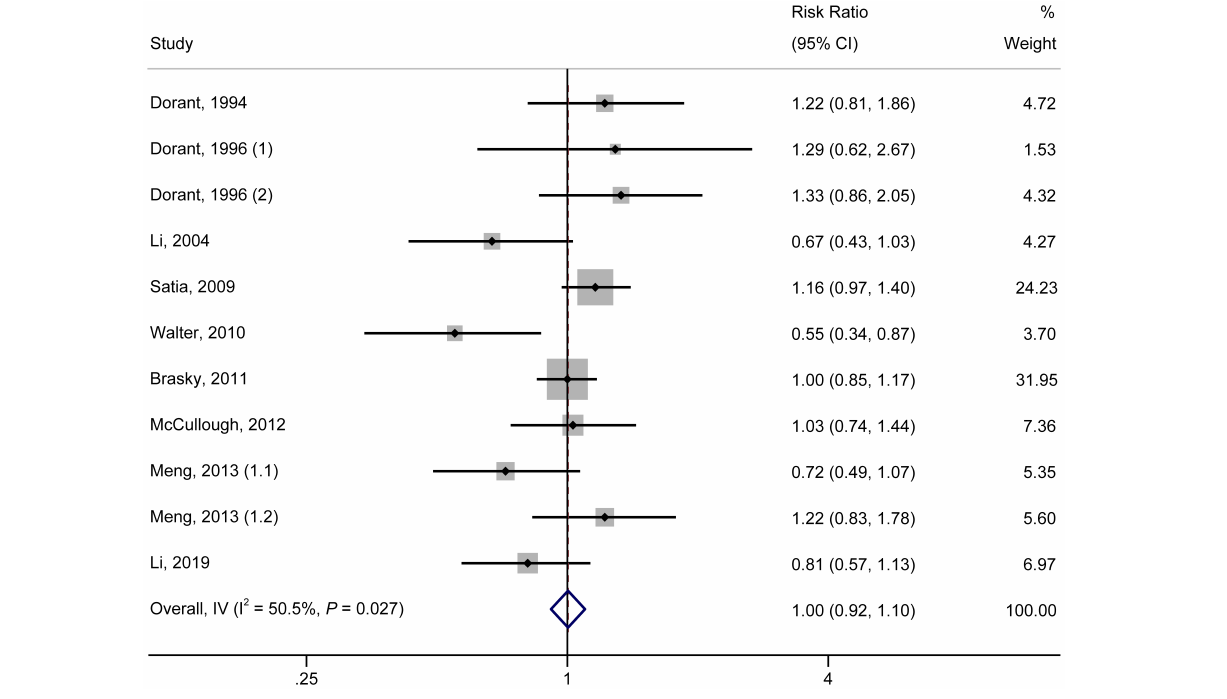
FIGURE 2 | Forest plot of the association between garlic supplement consumption and cancer risk (highest vs. lowest category of supplement consumption).